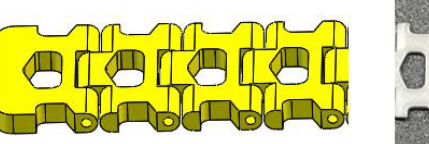
Figure 2. Finger endoskeleton.